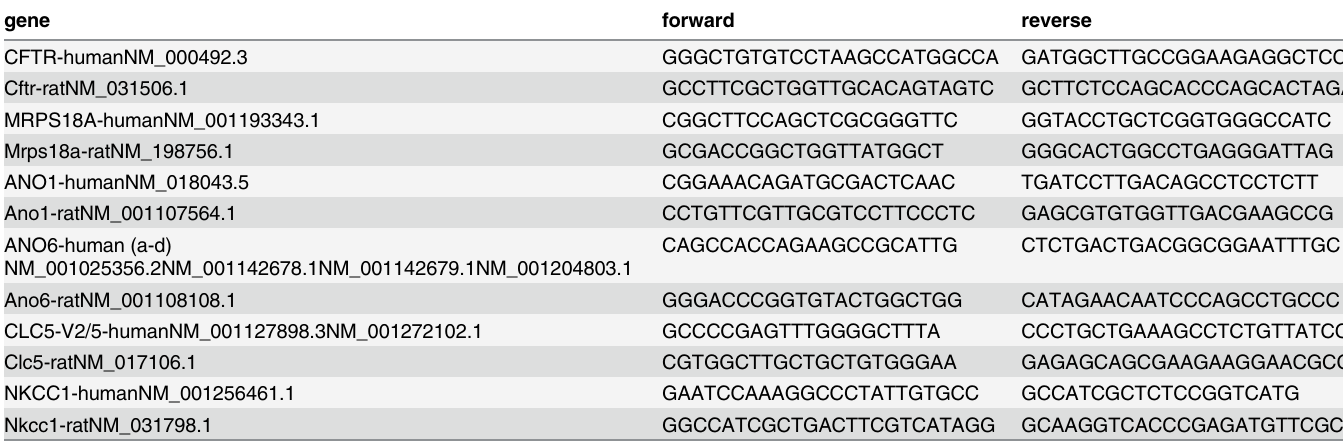
Table 1. Gene-specific